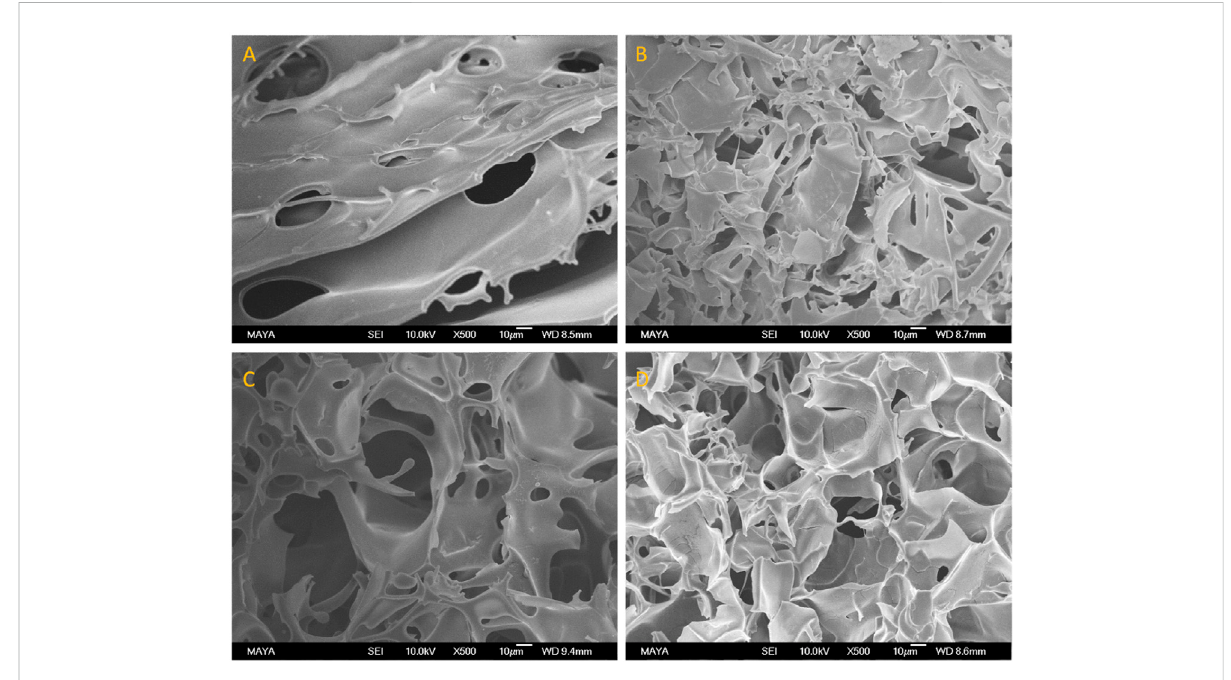
FIGURE 3 SEM images of (A) HEMA-CG, (B) HEMA-BSA-CG, (C) Am-CG, and (D) Am-BSA-CG. The scale bar is 10 μ